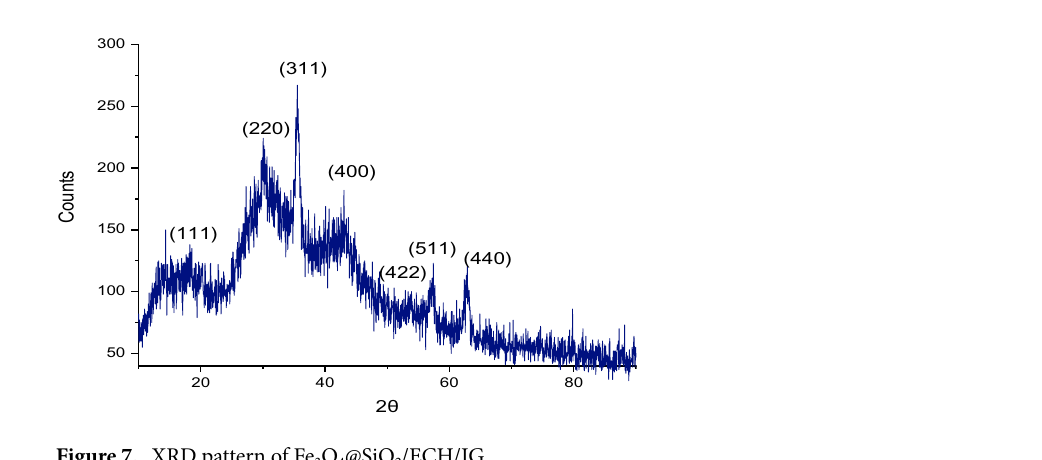
Figure 6. VSM analysis of the prepared Fe 3 O 4 @SiO 2 /ECH/IG.